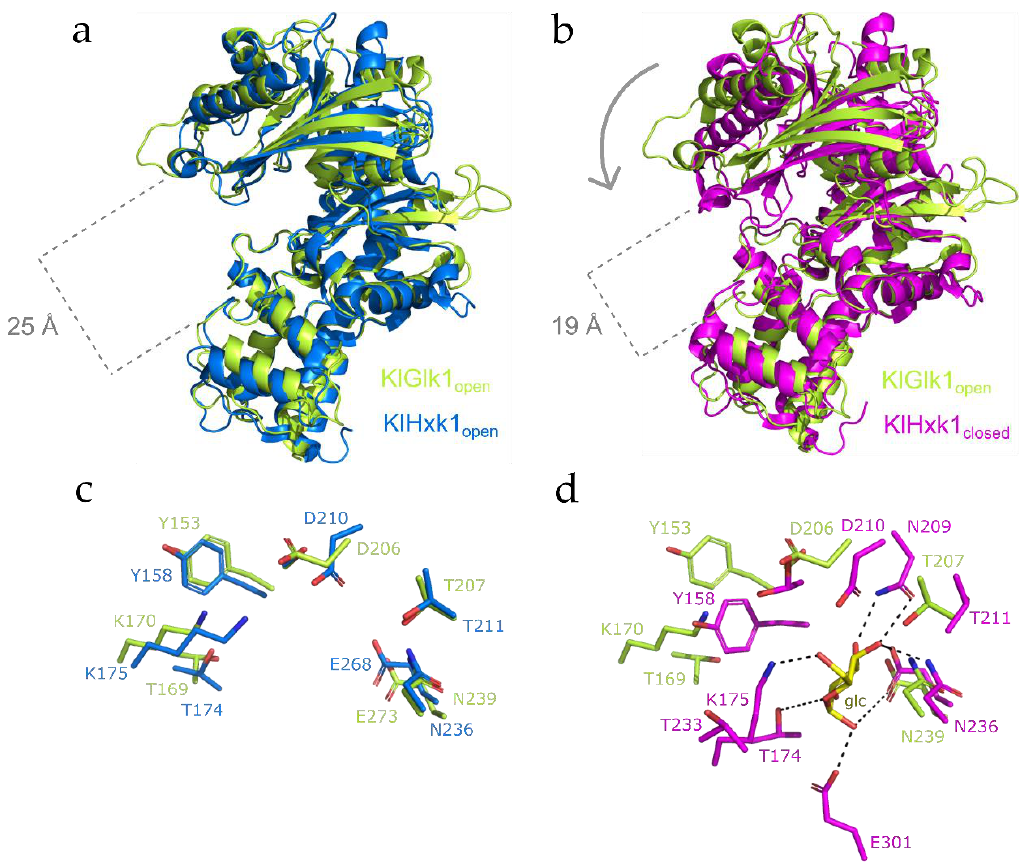
Figure 3. Comparison of crystal structures of Kl Glk1 and Kl Hxk1 kinases. ( a ) Superposition of Kl Glk1 and KlHxk1 (PDB:3o08) in open states. ( b ) Superposition of Kl Glk1 in the open state and Kl Hxk1 in